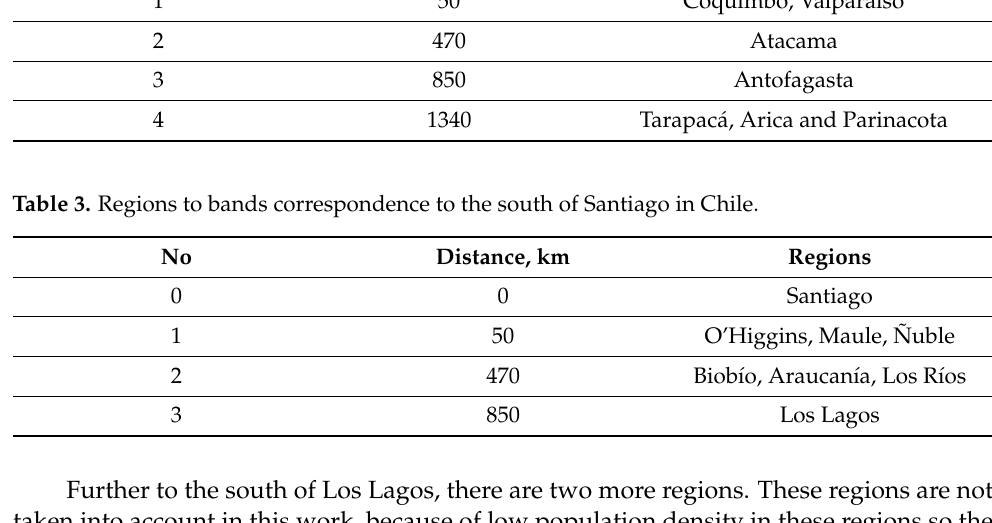
Table 2. Regions to bands correspondence to the north of Santiago in Chile.